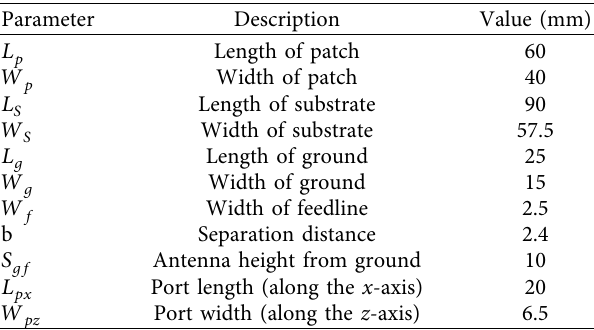
Table 1: Optimized dimensions for the Z -shaped meander-line patch